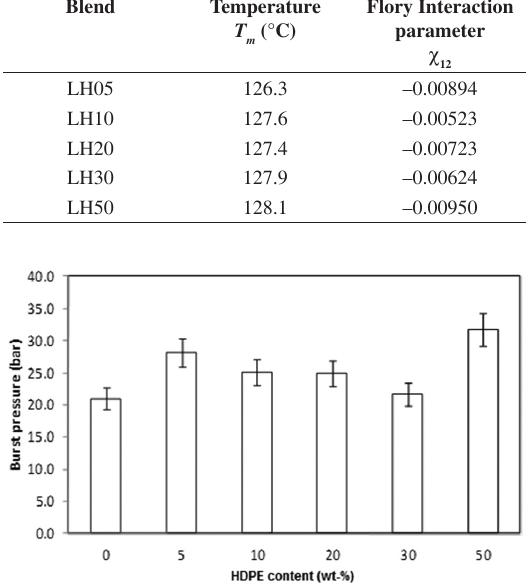
Figure 5. Burst pressure results of the liners produced with the blends (wall thickness = 5 mm).